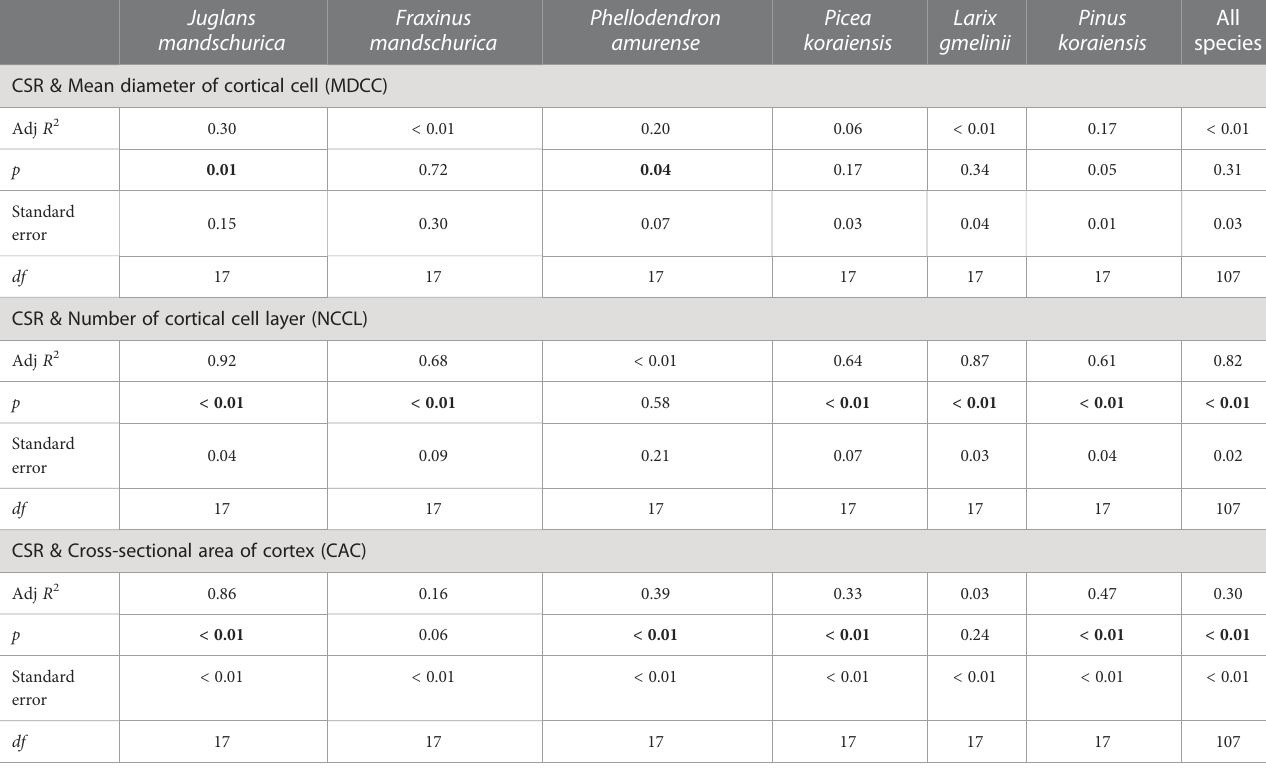
TABLE 5 Group-wise regression of the ratio of unilateral cortex thickness to stele radius (CSR) and cortical cells traits in three angiosperms and three gymnosperms tree species. Juglans